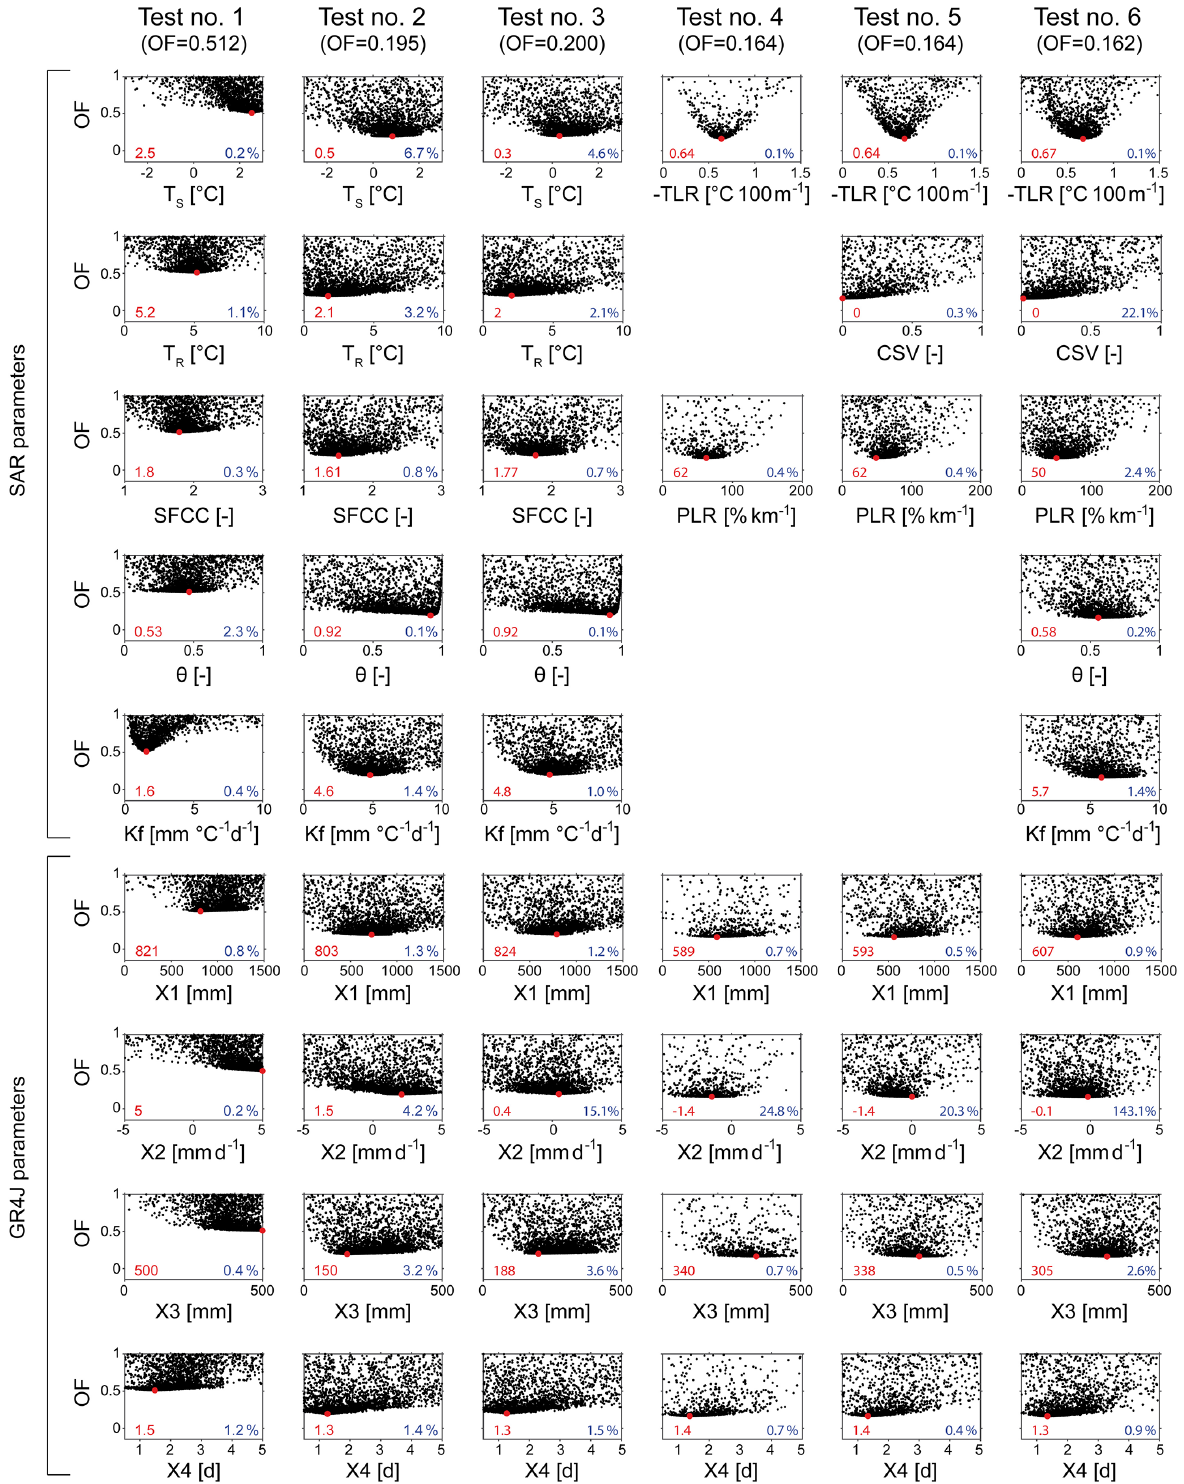
Figure 8. Parameter sensitivity to the objective function (OF) according to Test nos. 1 to 6 (see Table 5) with GR4J combined with the snow accounting routine (SAR) on the Durance at Serre-Ponçon. The values and dots in red indicate the optimized calibrated parameters when minimizing OF, the black dots represent trials of the SCE-UA optimization algorithm, and the values in blue are the variation coefficients (in %) of the 20% best-performing parameter solutions compared to the optimized values for each parameter (the lowest value, the easiest parameter identifiability). Note that, depending on the tests, the calibrated parameters of the SAR vary from 2 to 5 (see Tables 2 and 5), while the GR4J hydrological model has four free parameters (see Table